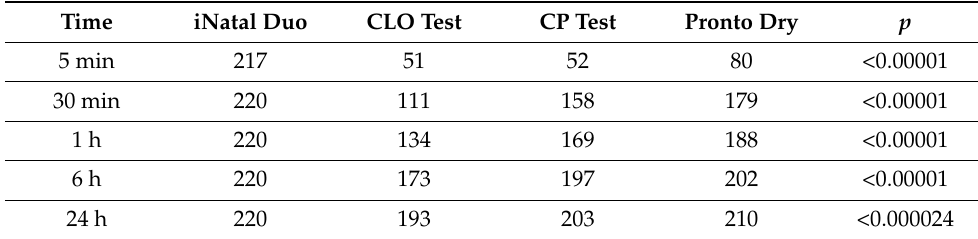
Table 1. Number of Hp-positive patients (not taking PPIs) for RUTs at different time points. The total of Hp-positive patients at histologic examination was 225/924 (24.3%). Statistical comparison has been made by one-way ANOVA test and p values are reported.